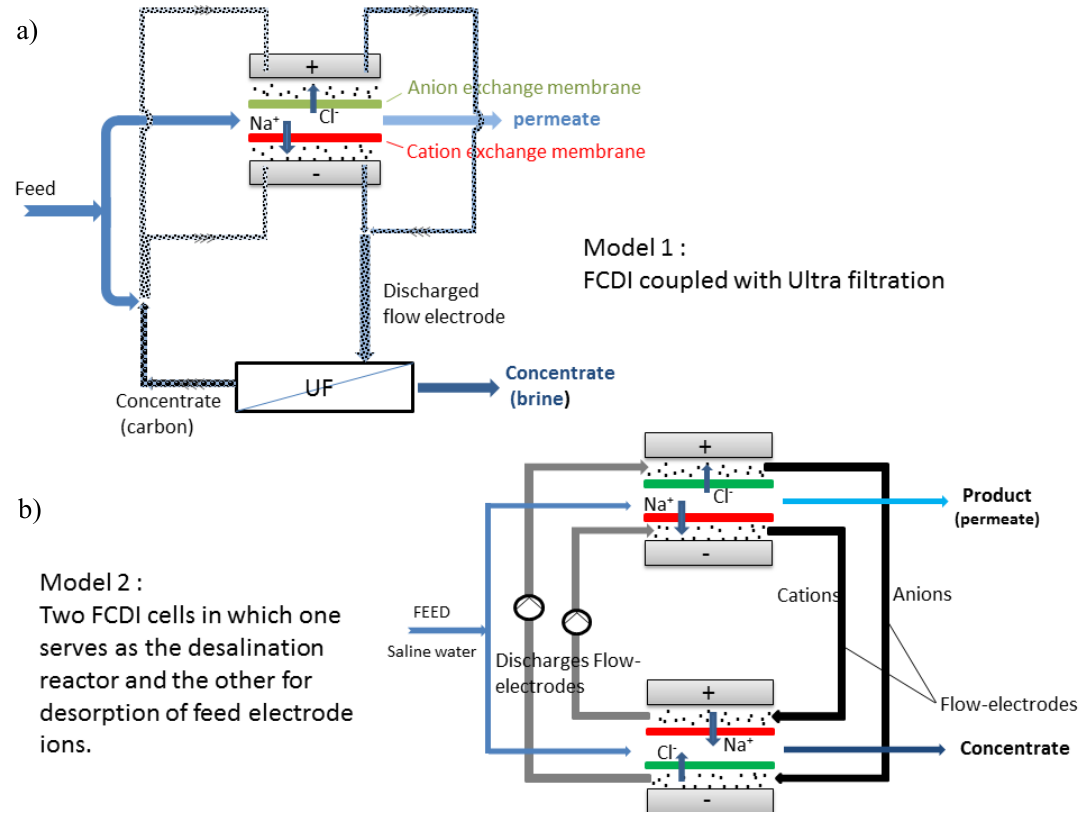
Figure 9. Schematic diagrams of FCDI in continuous mode via ( a ) FCDI coupled with ultrafiltration and ( b ) two FCDI cells.